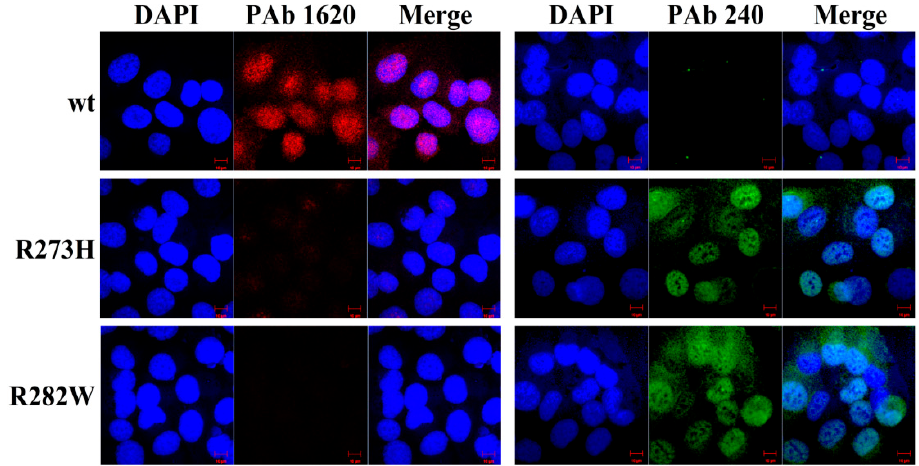
Figure 2. Immunofluorescence results of the different statuses of P53 (wtP53 antibody PAb 1620 stained with fluorescein-labeled secondary antibody (red, Alexa Fluor 555); mutP53 antibody PAb 240 stained with fluorescein-labeled secondary antibody (green, Alexa Fluor 488)). DAPI observed the cell nucleus. Representative scopes are shown ( n = 3). The objective lens is 100 × magnifications and the scale bar represents 20 µ m.